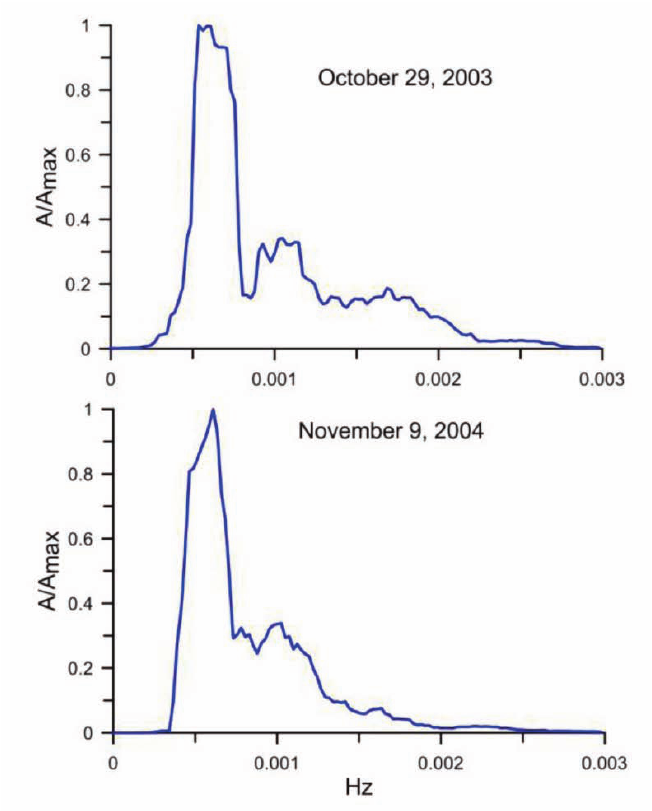
Figure 4. Normalized spectra of the filtered (0.28-15 mHz) amplitudes of the NRK signals registered at the Bari station during strong magnetic activity in October 2003 and November